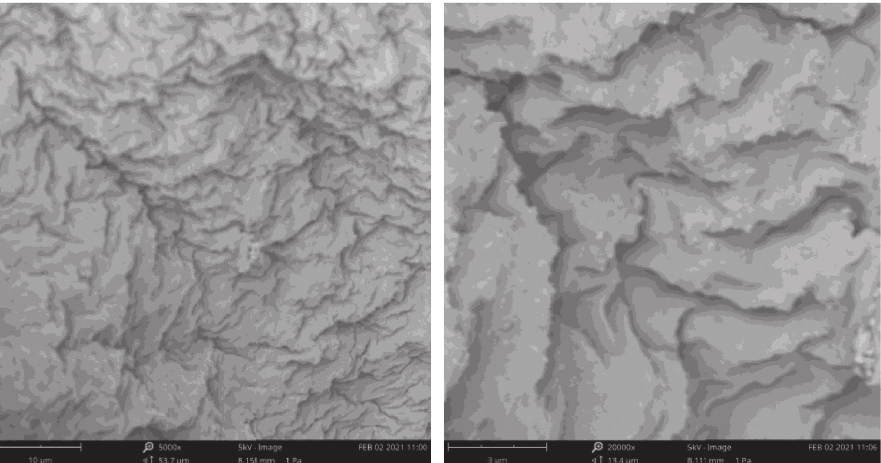
Figure 2: Scanning electron microscope observation of Inonotus obliquus -purified oligosaccharide IOP-2A.